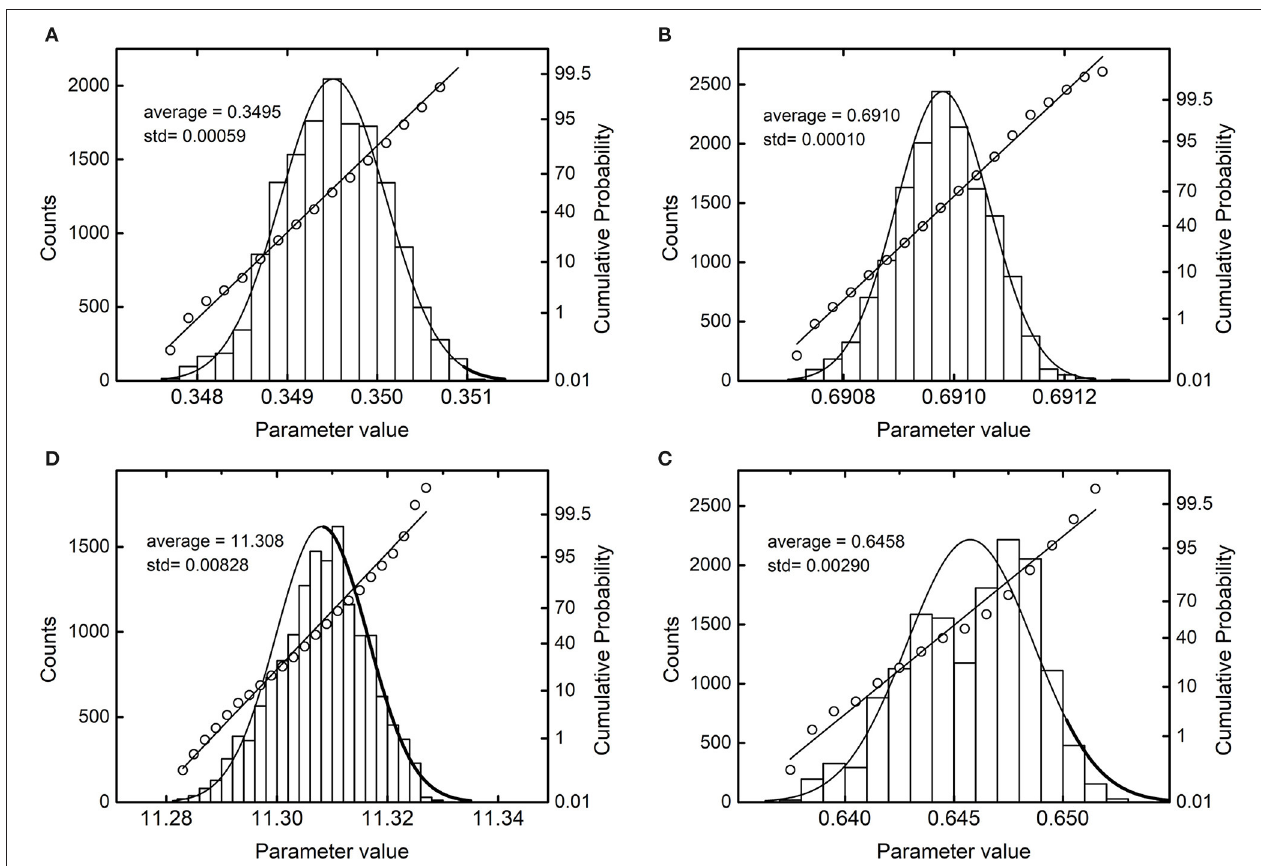
FIGURE 7 | Probability density plots and probit plots of a selection of parameters. (A) Dataset 21, parameter P1; (B) dataset 3, parameter P2; (C) dataset 4, parameter P3; (D) dataset 10, parameter